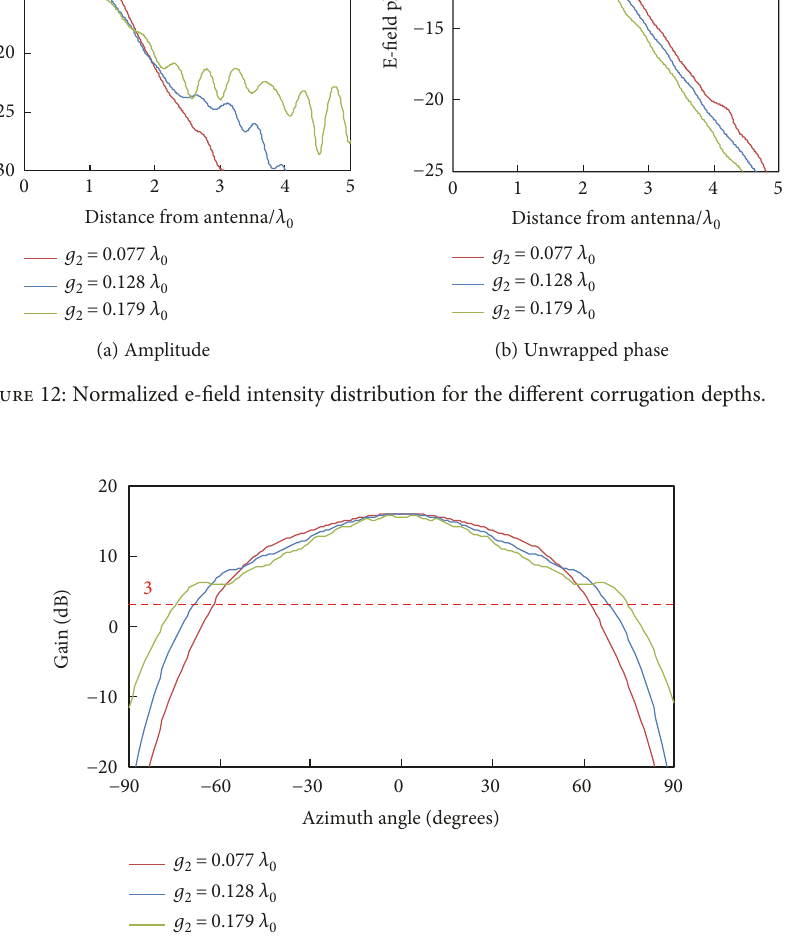
Figure 13: The 3 dBi beam width comparison for the di ff erent corrugation depths. Table 4: 3dBi beam widths of the di ff erent corrugation